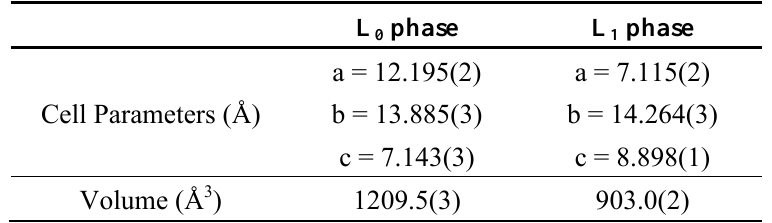
and L phases. 0 1